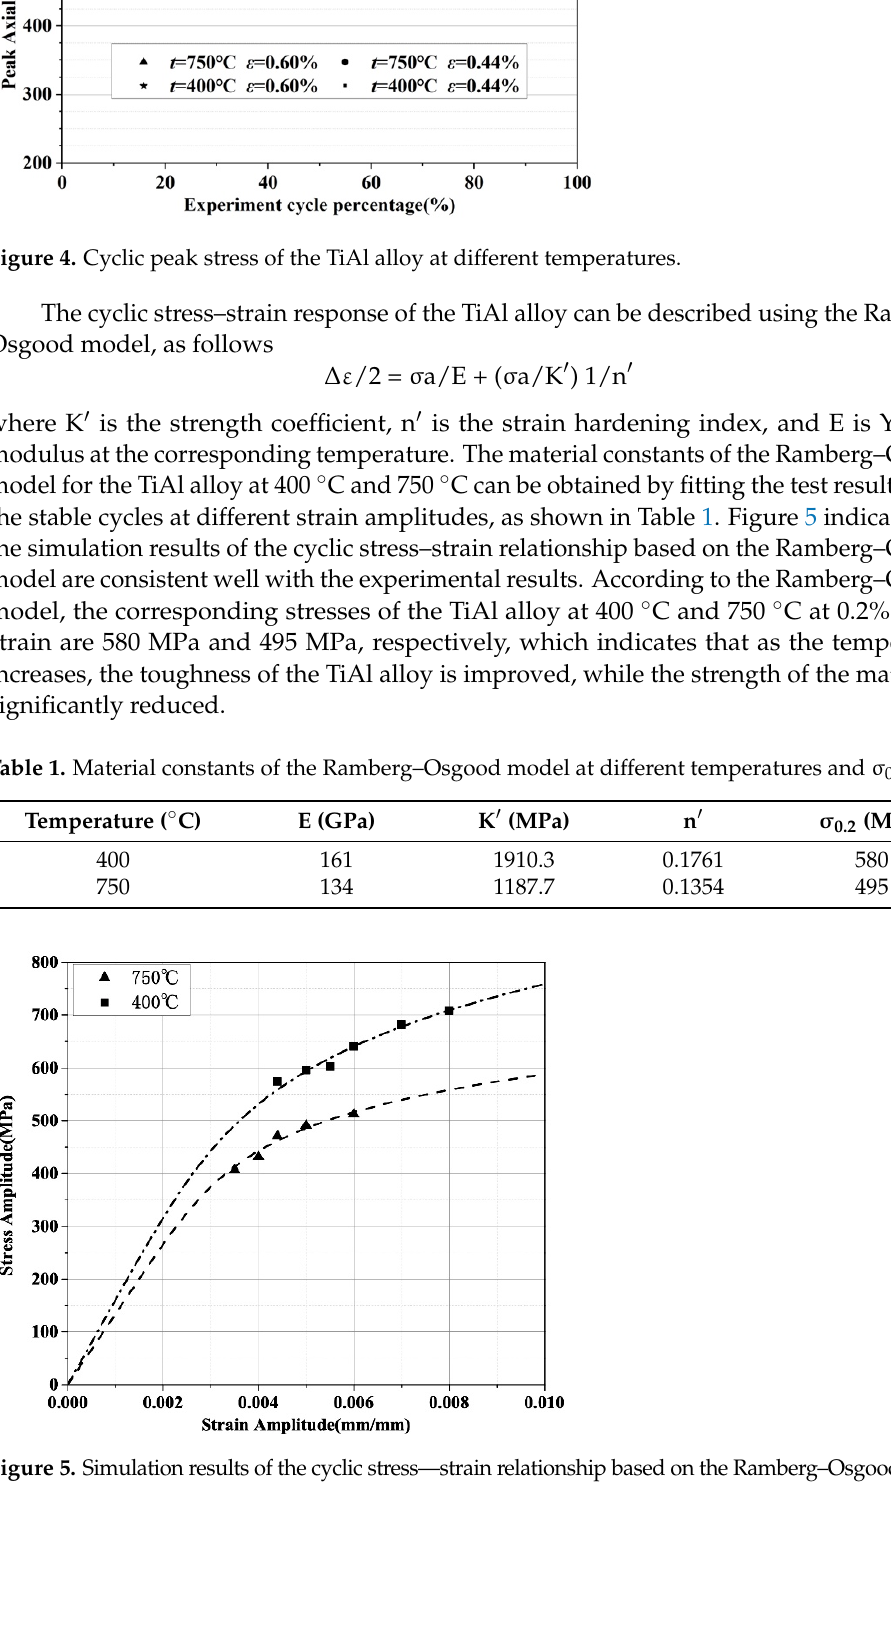
Figure 3. Stable stress-strain curves of the TiAl alloy at ( a ) 400 °C and ( b ) 750 °C.